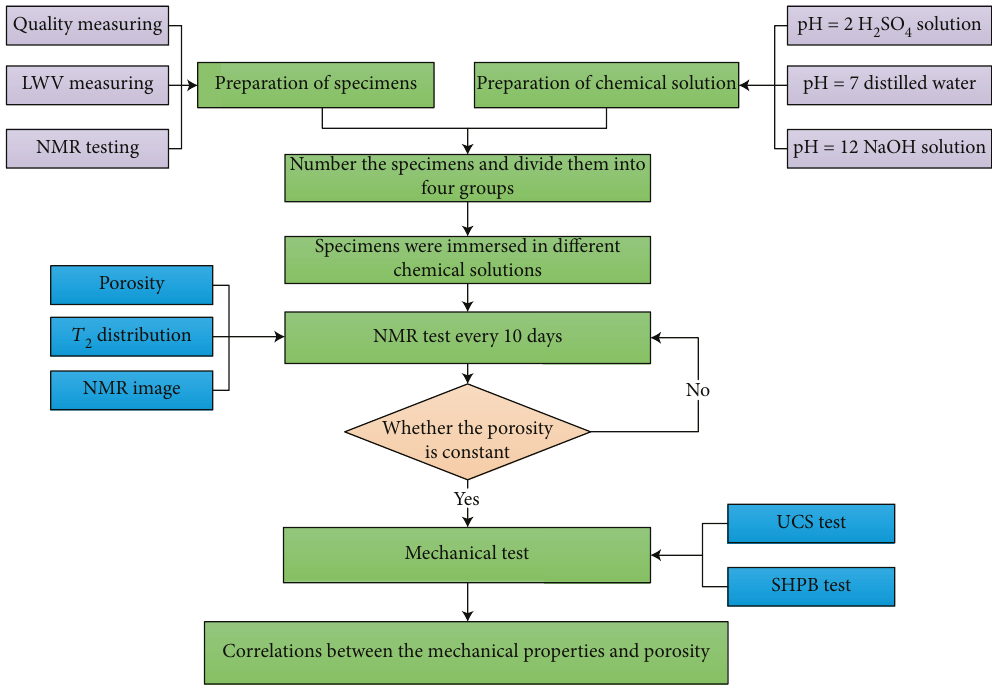
Figure 1: Flow chart of the complete experiment